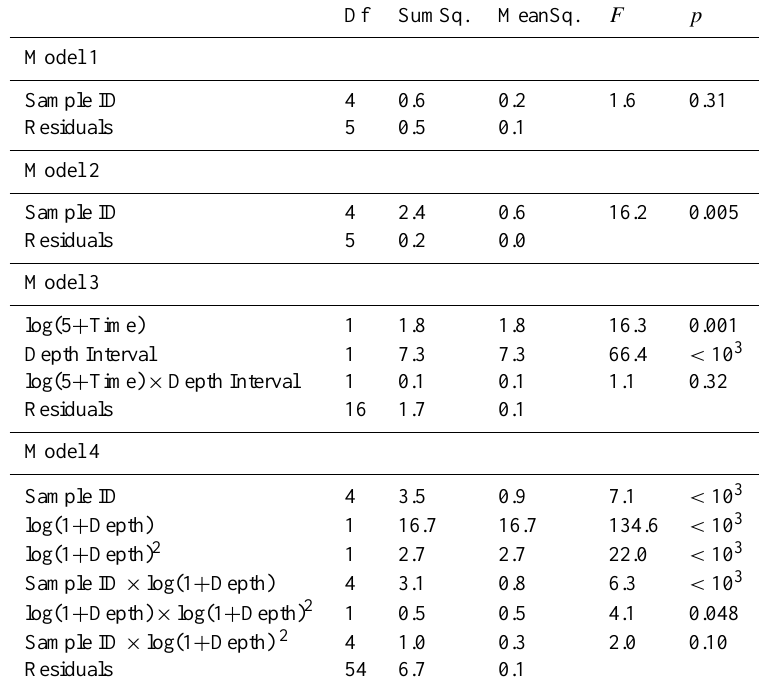
Table 4. Results of the models 1, 2, 3 and 4. For each model, the degrees of freedom (Df), the sum and mean of squares (SumSq. and MeanSq.), the F value ( F ) and its p value ( p ) are given for each variable. The p values indicate whether the variable has a significant effect ( p < 0 . 05) or not ( p > 0 . 05). Df SumSq.